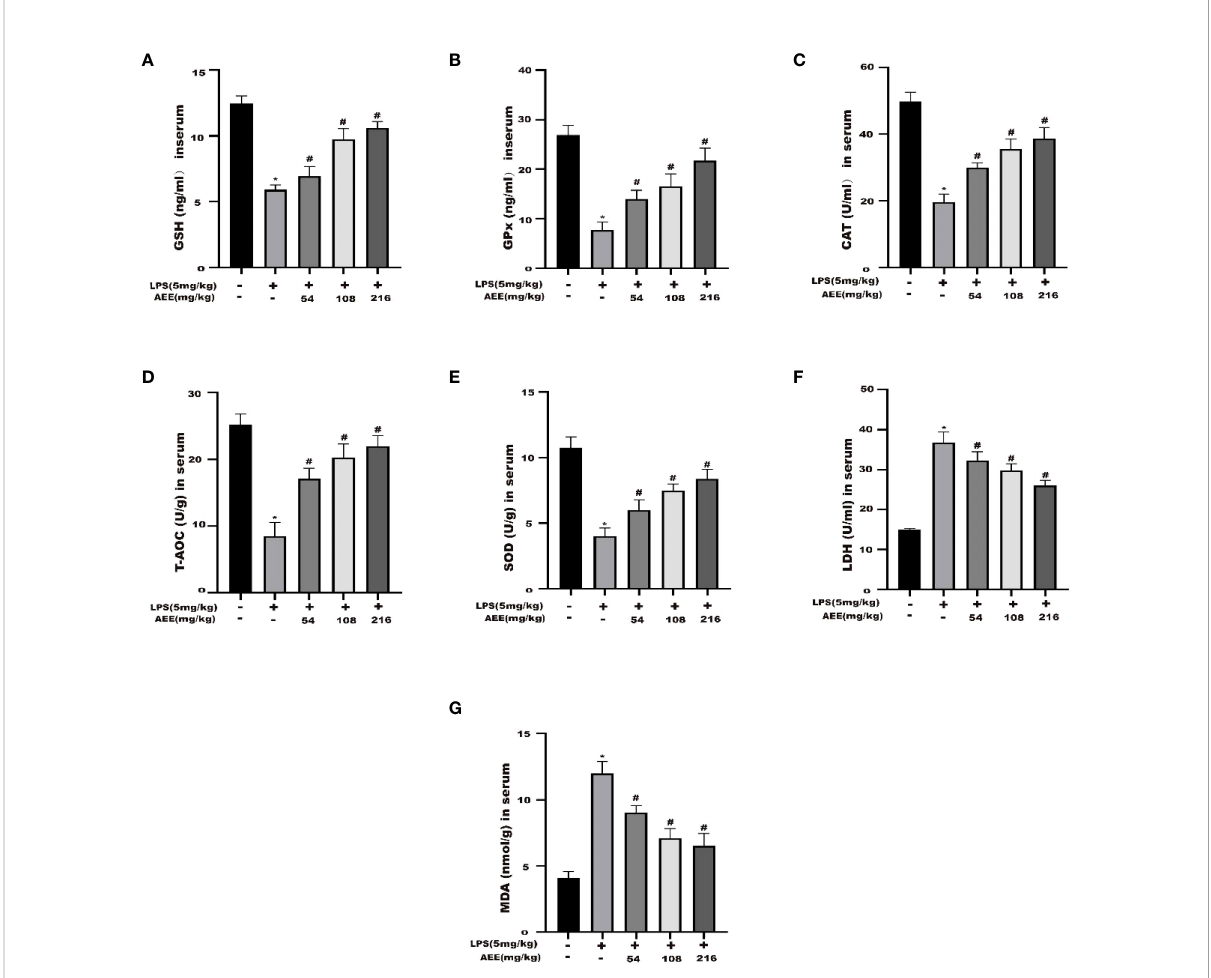
FIGURE 7 Effect of AEE on the level of oxidative stress in LPS-induced ALI rats. (A) GSH, (B) GPx, (C) CAT, (D) T-AOC, (E) SOD, (F) LDH, (G) MDA. Values are presented as the means ± SD where applicable ( n = 8). * P < 0.05 compared to control group, # P < 0.05 compared to LPS